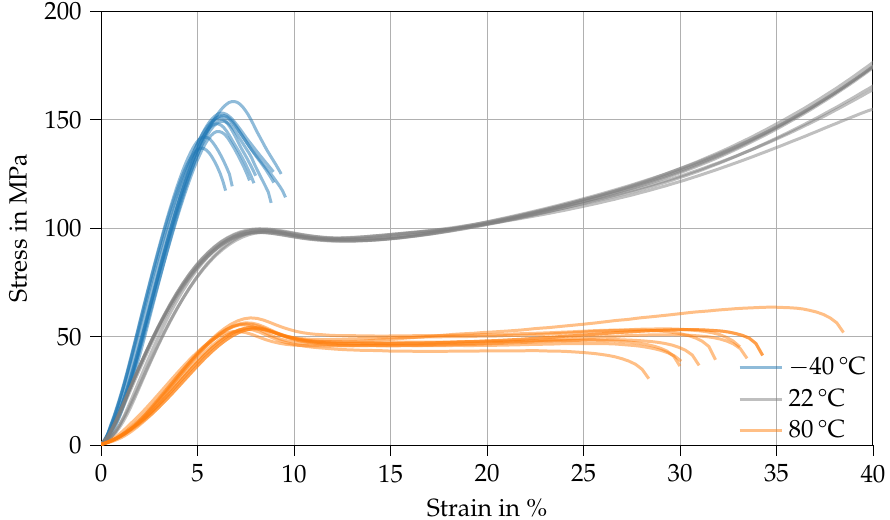
Figure 5. Stress–strain curves derived from compression strength tests of Argopox at T = − 40°C (blue), 22°C (gray), and 80°C